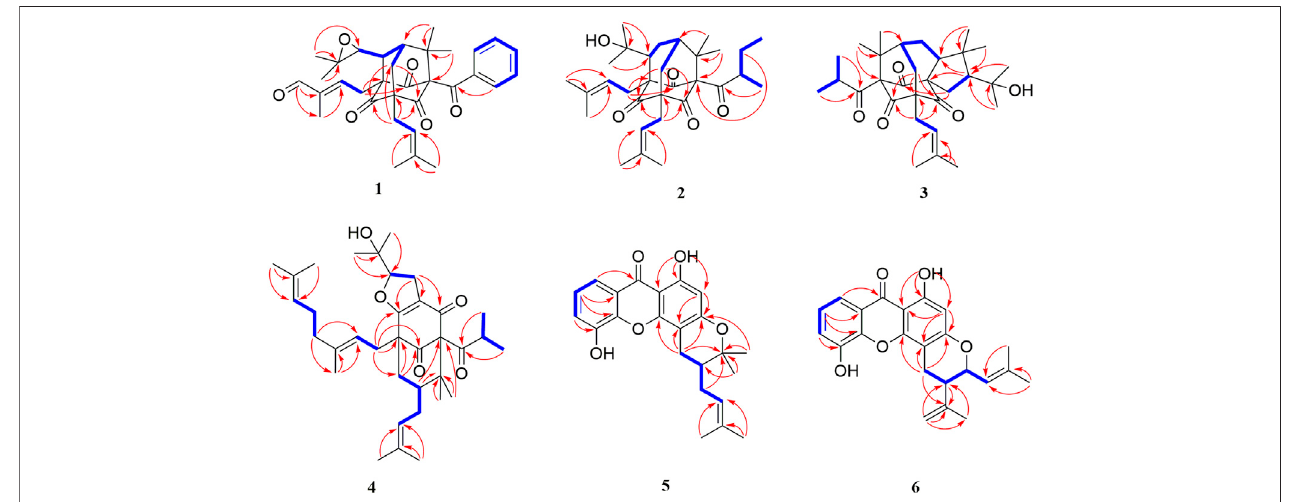
FIGURE 2 | 1 H – 1 H COSY and key HMBC correlations of compounds 1-6